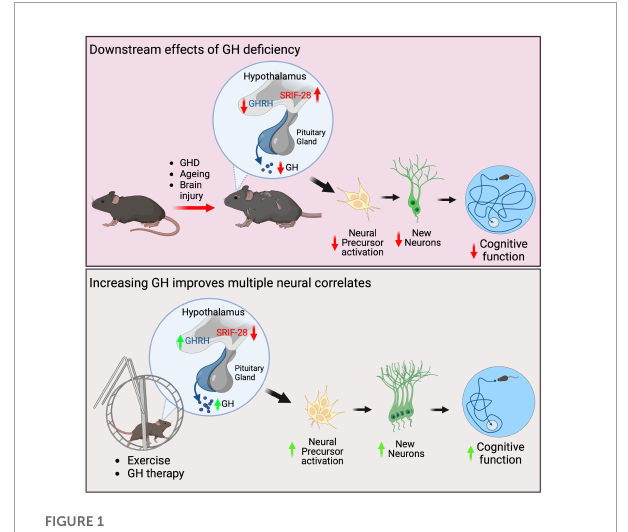
FIGURE1 Schematics summarising the neural effects due to GHD and following GH replacement therapy in mice. GHD due to ageing or brain injury can result in hypothalamic dysfunction where GHRH is decreased and somatostatin, including somatostatin-28 (SRIF-28) is increased. This results in a decrease in GH secretion from the pituitary gland. Downstream of this reduction is a decrease in endogenous neural precursor cell activation, a decrease in neurogenesis and deficits in cognitive function, including spatial learning. Increasing GH levels either through physical exercise or GH therapy increases neural precursor cell proliferation, increases neurogenesis and improves cognitive